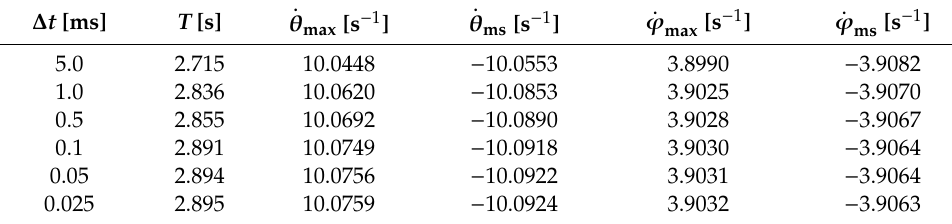
Table 3. Bell 1 ringing right. Convergence test for the proposed procedure.